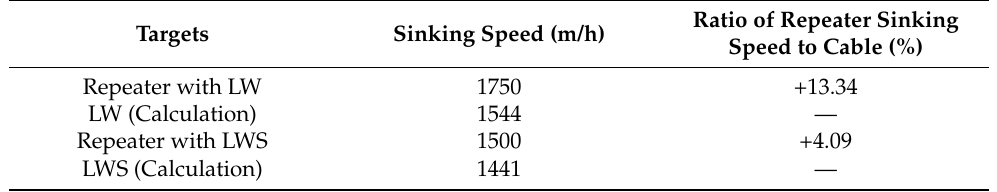
Table 2. Comparative sinking speed between repeater and